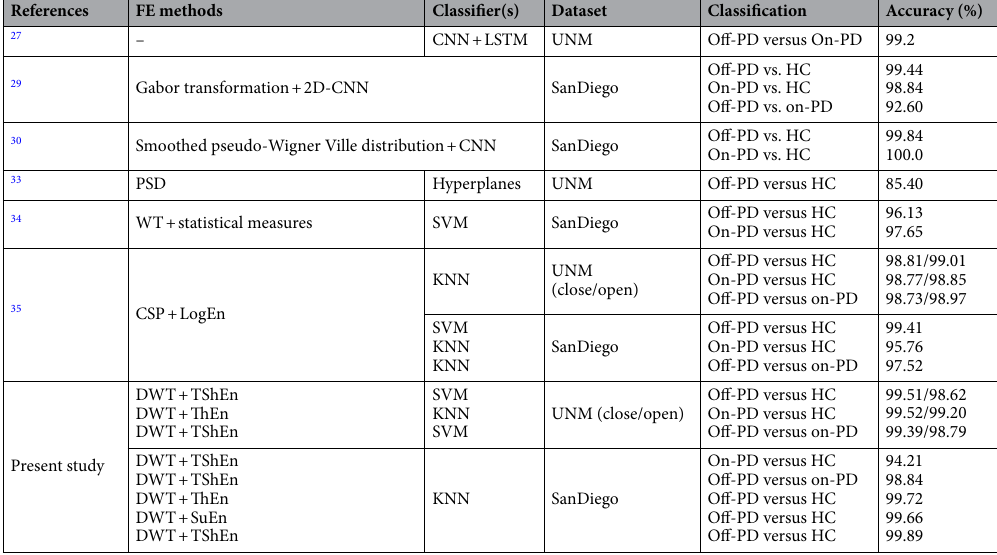
Table 13. Summary of PD detection studies that used the same publicly available PD